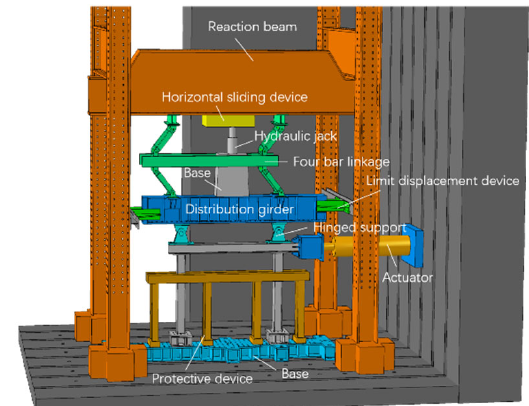
Figure 7. Test setup.